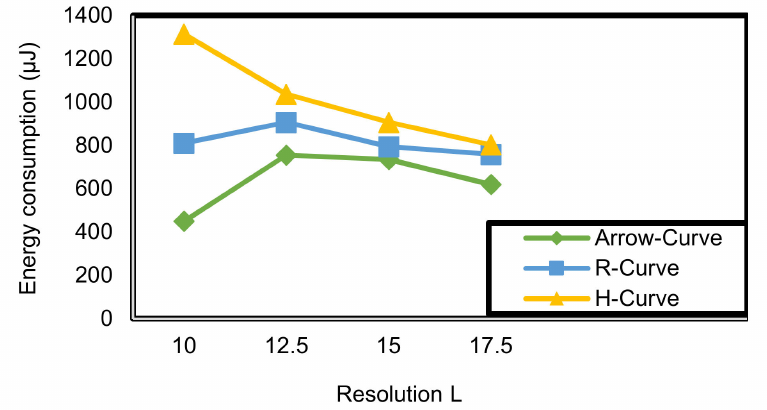
Figure 16. Power consumption (mw) corresponding to resolution (L) in Arrow-Curve model, R-Curve path model, and H-Curve.